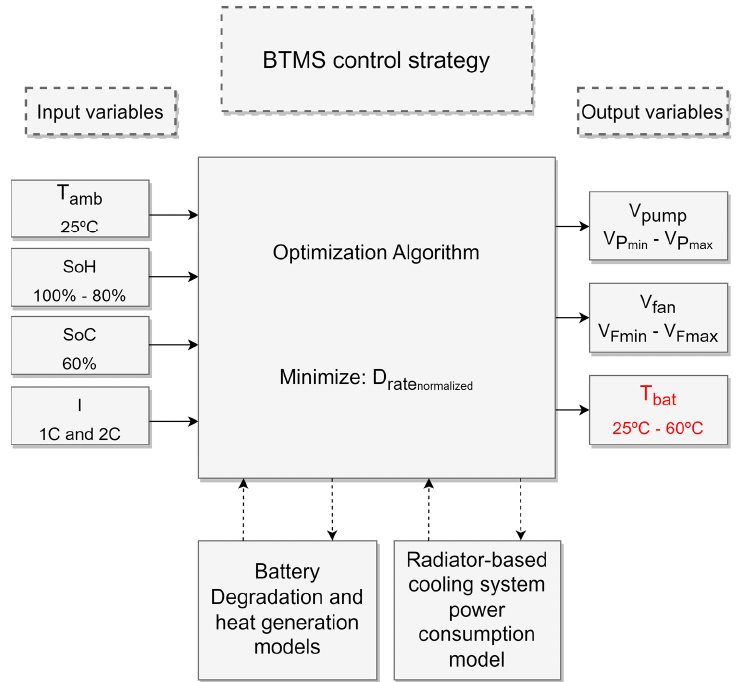
Figure 9. Case study summarization as an optimization